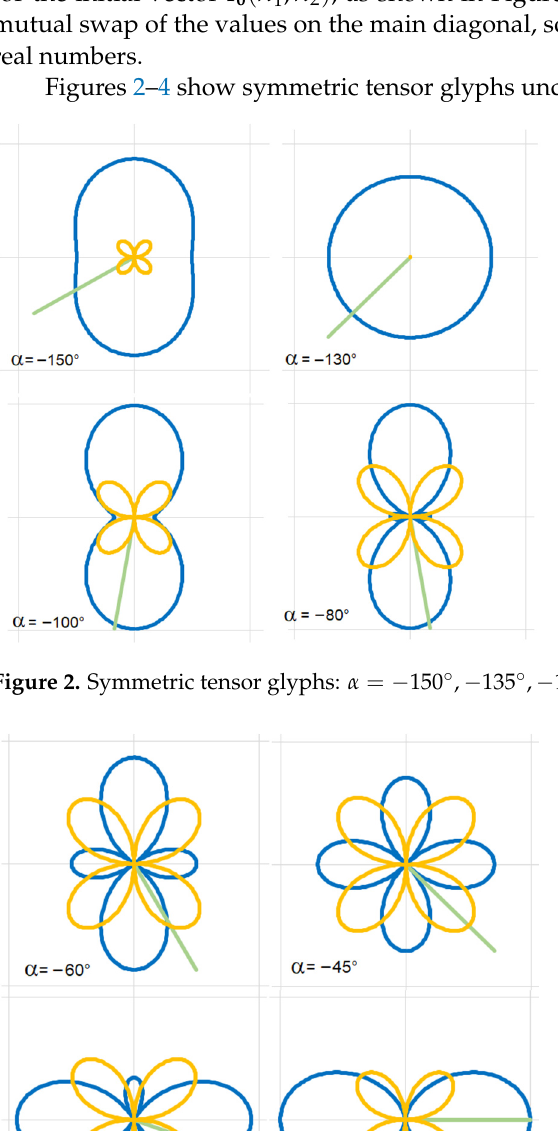
Figure 1. Symmetric tensor and its components rotated by ( a ) 𝜑 = 60° and ( b ) 𝜑 = 360° . Figures 2–4 show symmetric tensor glyphs under various angles 𝛼 .